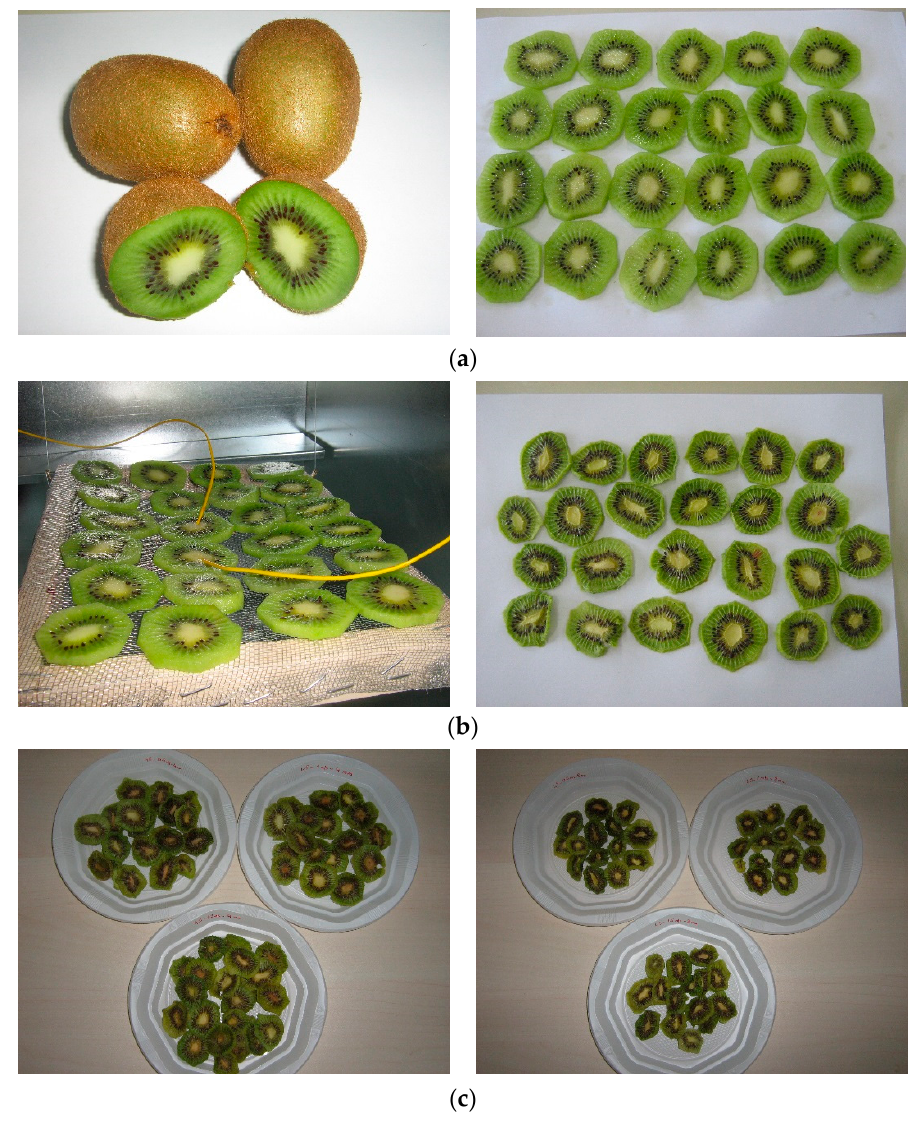
Figure 2. View of kiwi fruits used in this study, ( a ) Fresh kiwi fruits, ( b ) The view of the kiwi fruits in the dryer chamber (in left ) and the view of the dried kiwi fruits (in right ), ( c ) The view of the dried kiwi fruits for slice thickness of 4 mm (in left) and dried kiwi fruits for slice thickness of 8 mm (in right).